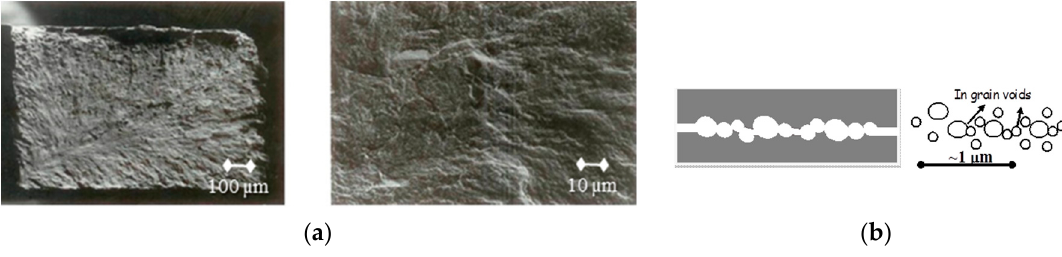
Figure 13. Quasi-cleavage of ( a ) specimen of 20%CW A316 (EBR-II, 460 °C, 78 dpa, 3–8% of void swelling) after tensile test at RT. Detail in right showing many fine voids. Adapted and modified according [31] with courtesy of F. A. Garner. ( b ) Scheme of the Quasi-cleavage fracture mechanisms—TG fracture owing cleavage rupture of bridges linking up micro-scale voids emphasizing that they are not deformed.